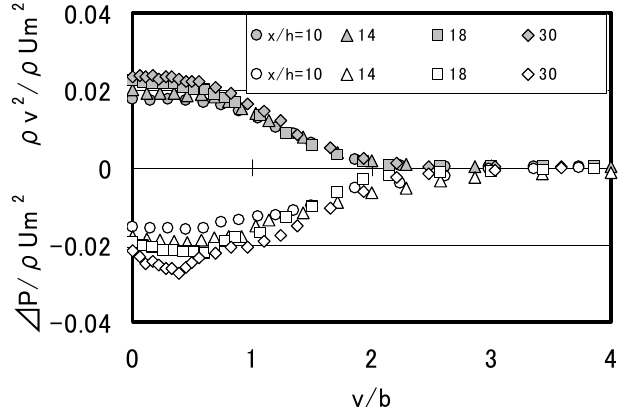
Fig. 16 Lateral Reynolds normal stress and mean pressure distributions ( Re =3.0×10 4